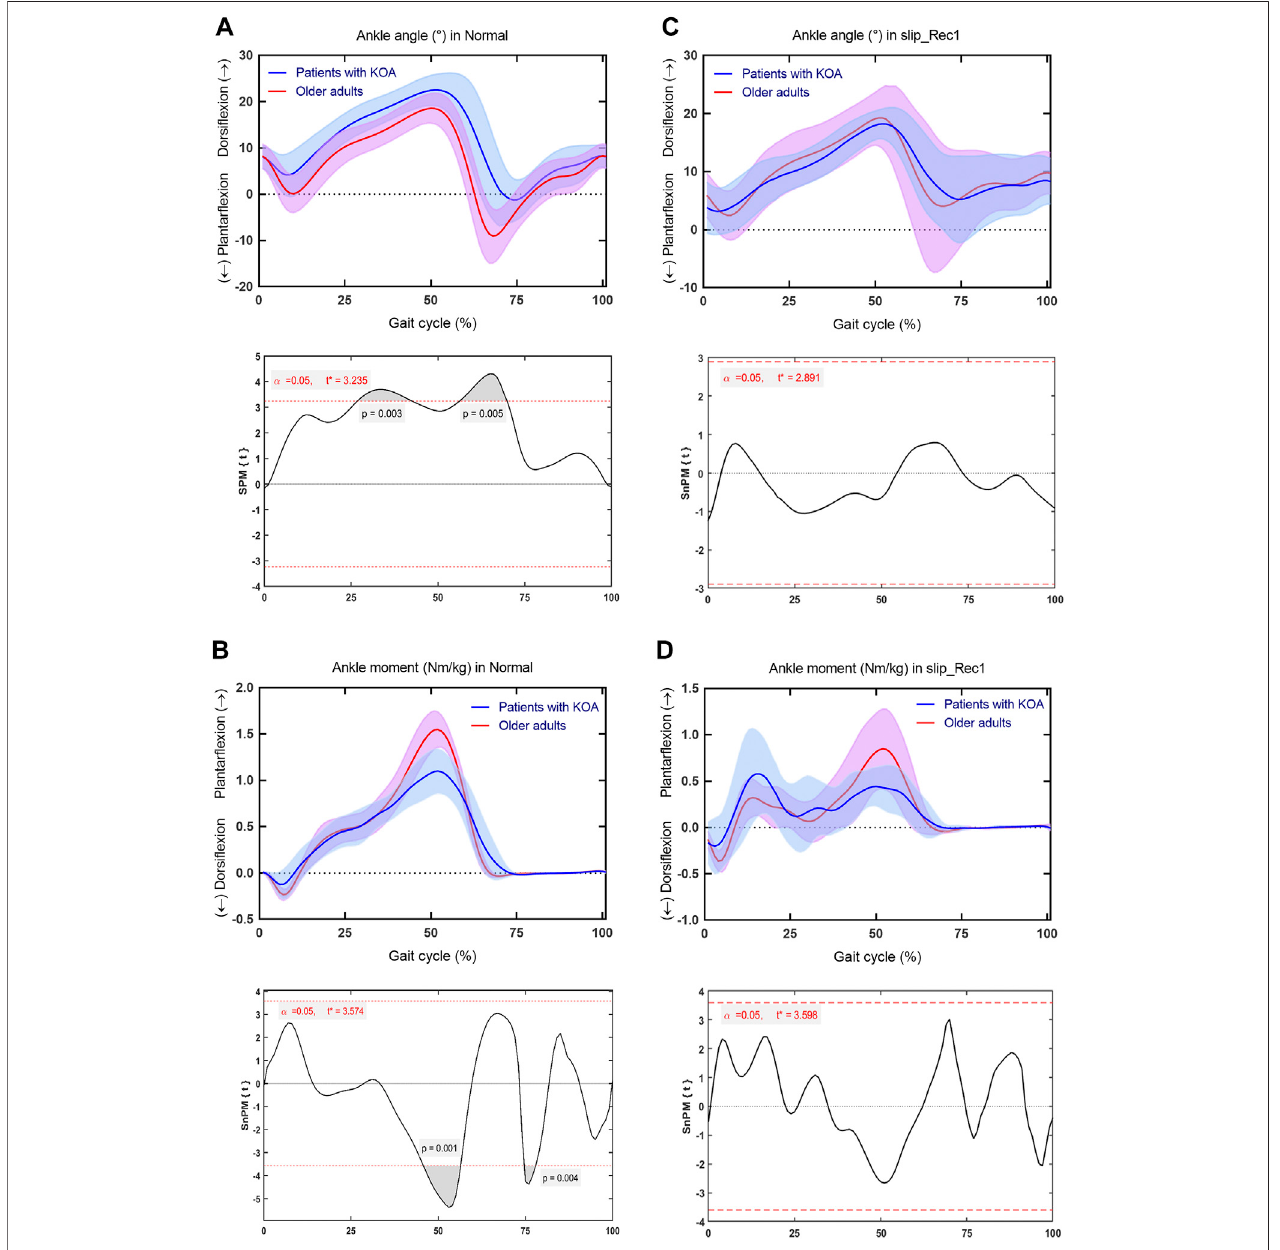
FIGURE 5 | Comparison between patients with knee osteoarthritis (KOA) and older adults for the ankle angle and ankle moment in Normal and slip_Rec1 in the sagittal plane. Ankle angle for patients with KOA and older adults in Normal (A) , ankle moment for patients with KOA and older adults in Normal (B) , ankle angle for patients with KOA and older adults in slip_Rec1 (C) , and ankle moment for patients with KOA and older adults in slip_Rec1 (D) . The upper and lower panels present the average and standard deviation of patients with KOA and older adults and the corresponding outcomes of the one-dimensional statistical parametric mapping (SPM) scalar trajectory t -test, respectively. Foreach analysis,the signi fi cance level isset at 0.05, and thecorrespondingt*ispresentedasthe horizontal red dashed line. The p valuesassociatedwiththesupra-threshold clusters, denoted asthe grey shaded regions, are presented whenever the test statistic continuumSPM{t}or SnPM{t} exceeds the